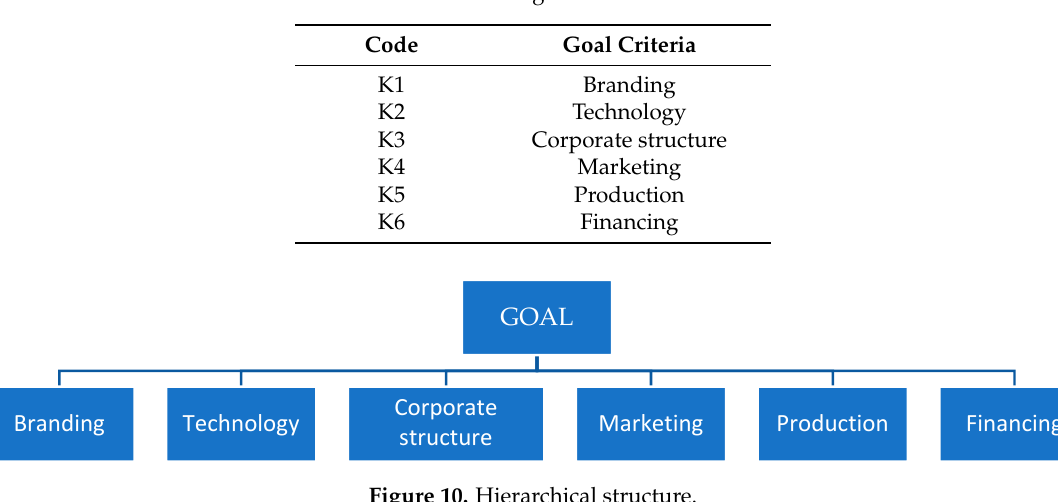
Table 4. Target Criteria.